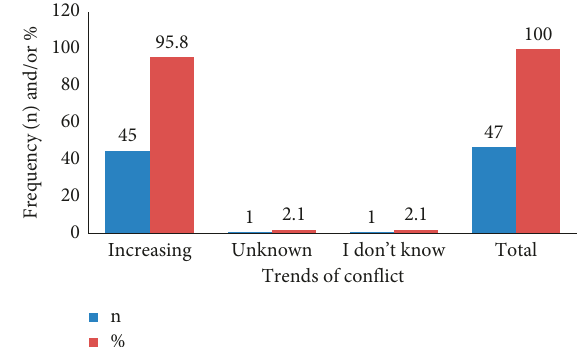
Figure 6: General trends of human-wild animal conflict in the study area.